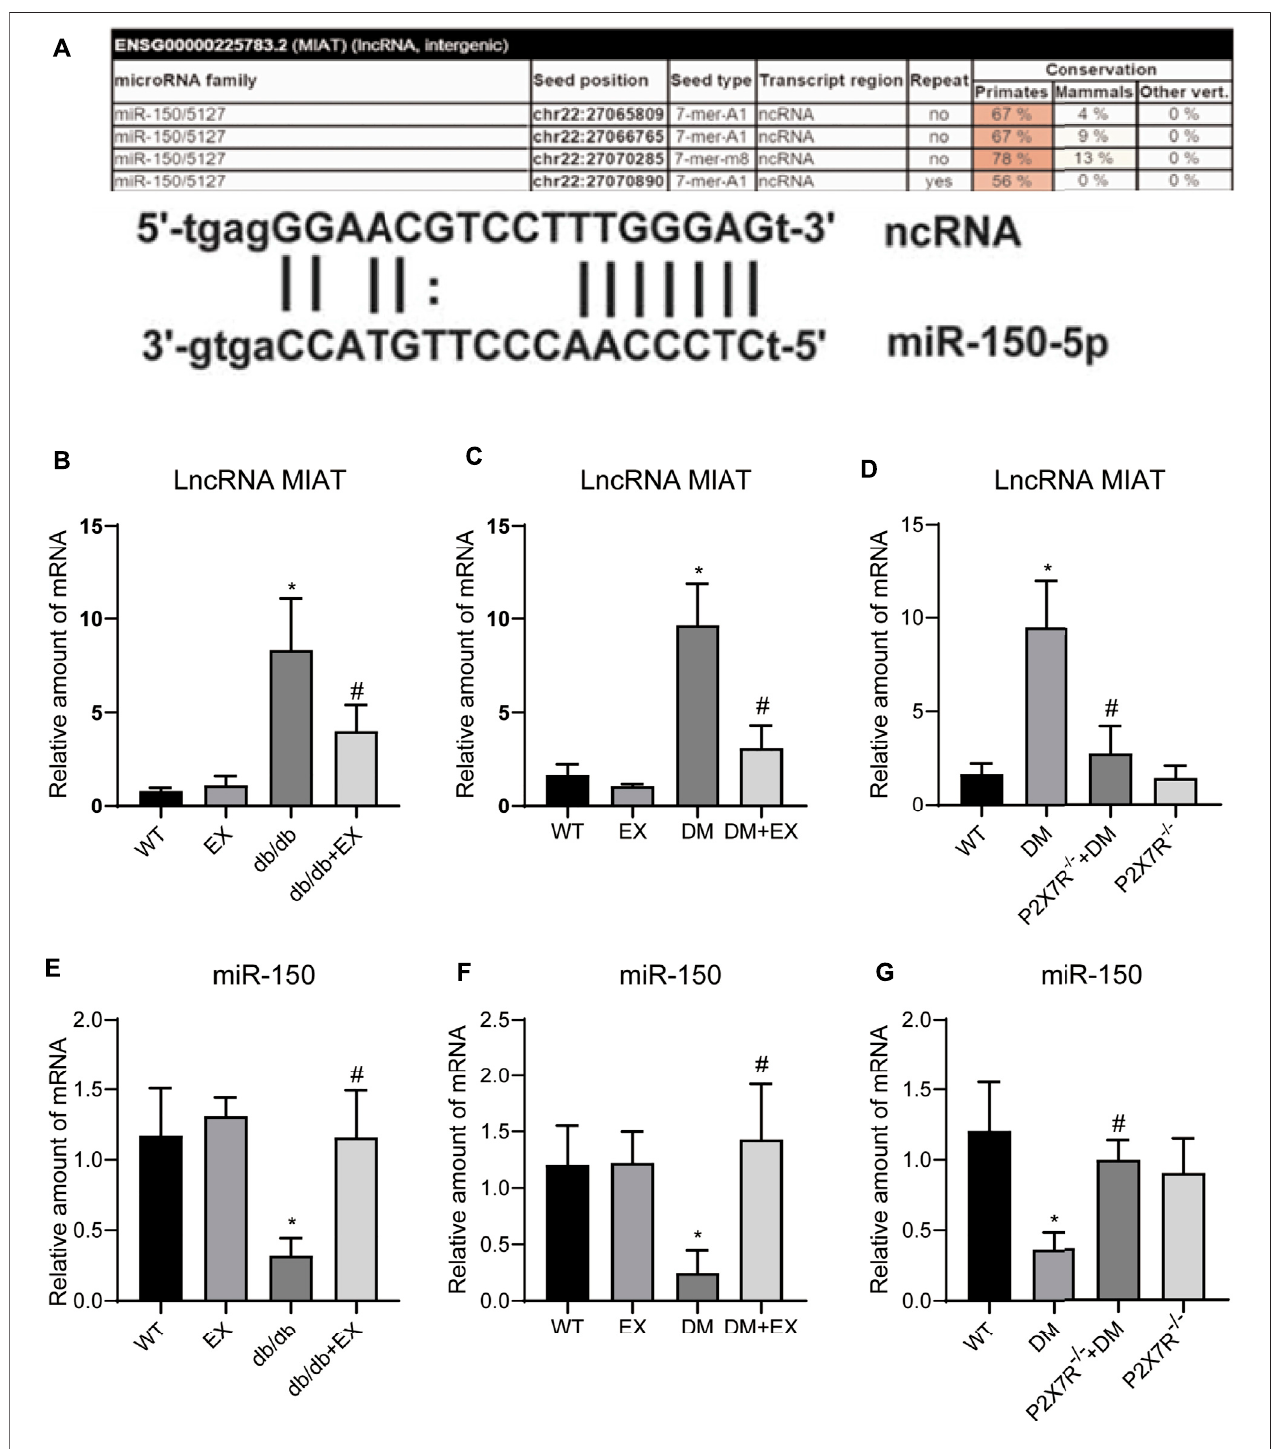
FIGURE12| P2X7RknockoutandexercisedecreasedlncRNAMIATandincreasedmiR-150. (A) ThebindingsiteoflncRNAMIATandmiR-150. (B – G) Thelevelof lncRNA MIAT and miR-150 in db/db mice and the DM group. * p < 0.05 vs. the WT group, # p < 0.05 vs. db/db group or the DM group.